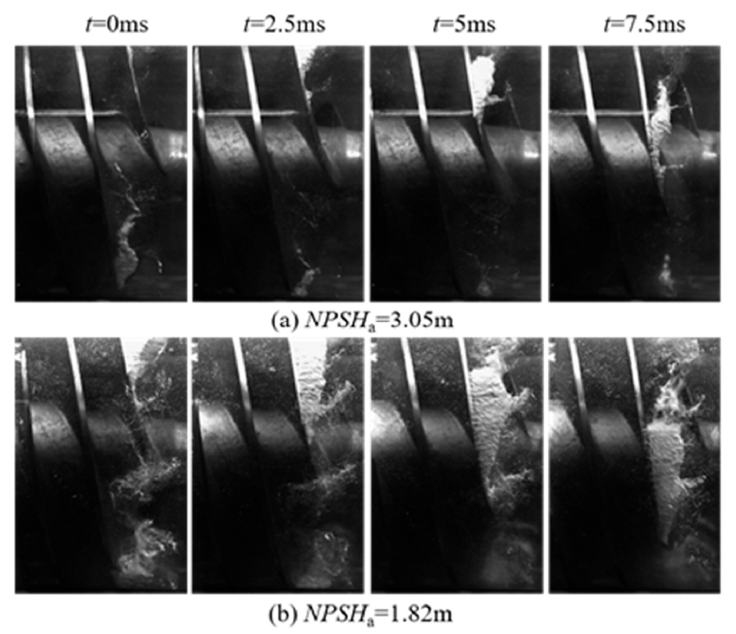
Figure 15. Evolution of the structure of the tip vortex cavitation under different NPSHa.